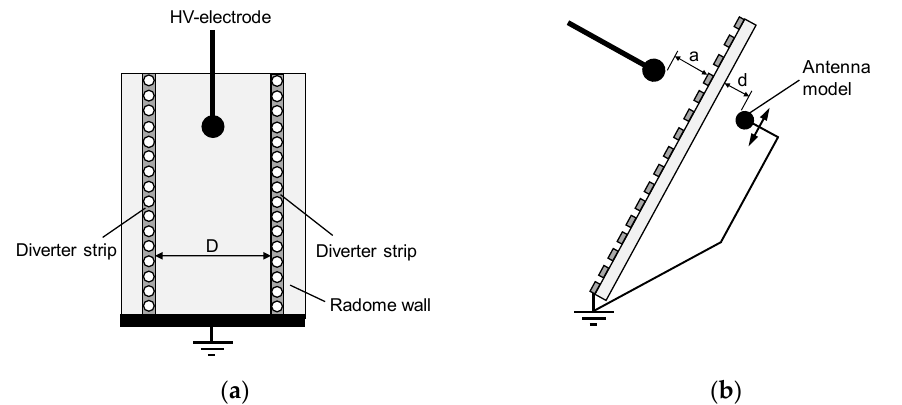
Figure 9. Schematic drawing of the test setup for the evaluation of maximum admissible interspacing between 2 diverter strips: ( a ) top view and ( b ) from the side.